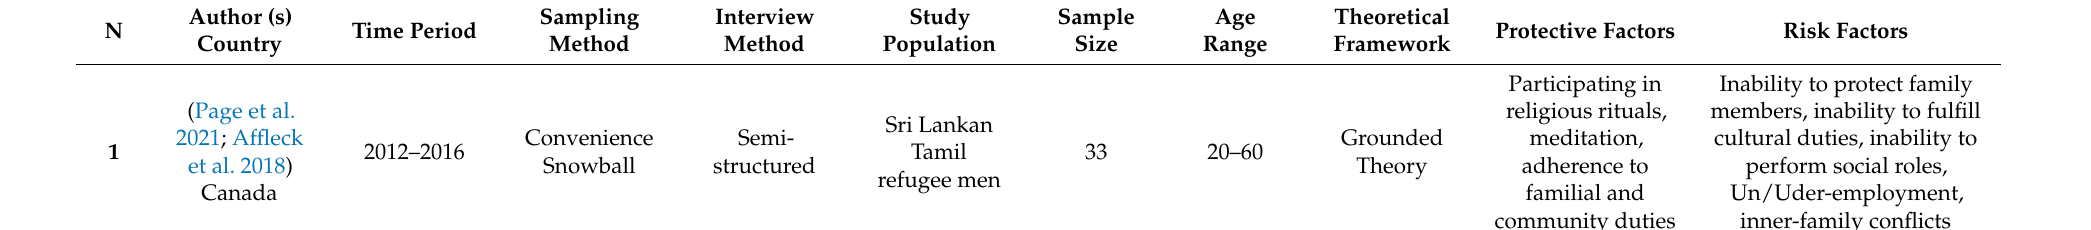
Table 1. Characteristics of the included qualitative